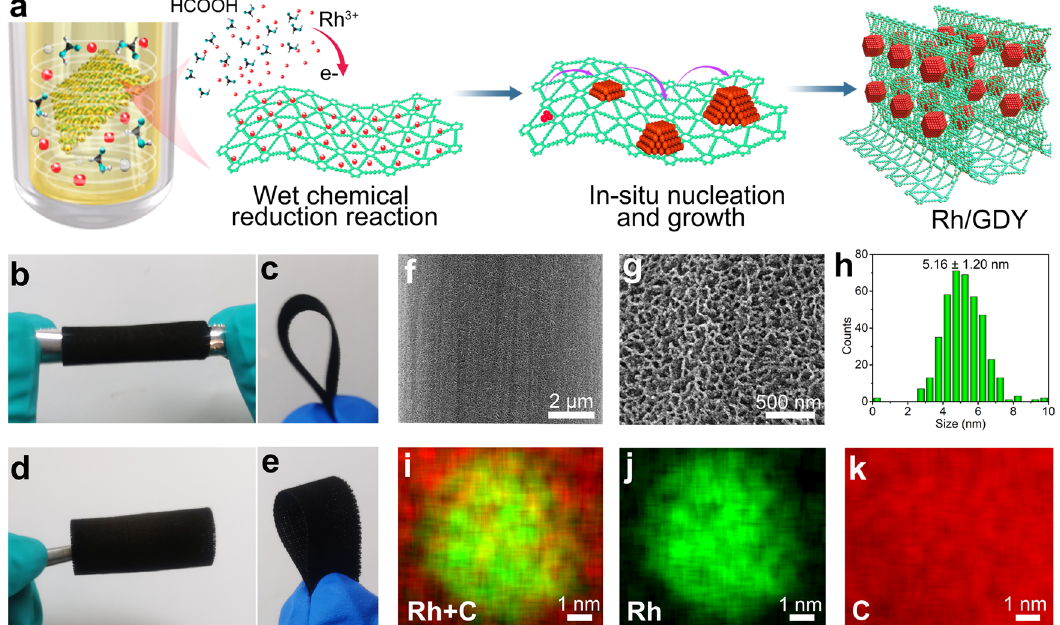
Fig. 1 | Synthesis and morphological characterization of Rh/GDY. a Synthesis routes to porous Rh/GDY electrodes. Optical images of b – e Rh/GDY electrodes withvariousbendingmorphologies. f Low-and g high-magni fi cationSEMimagesof